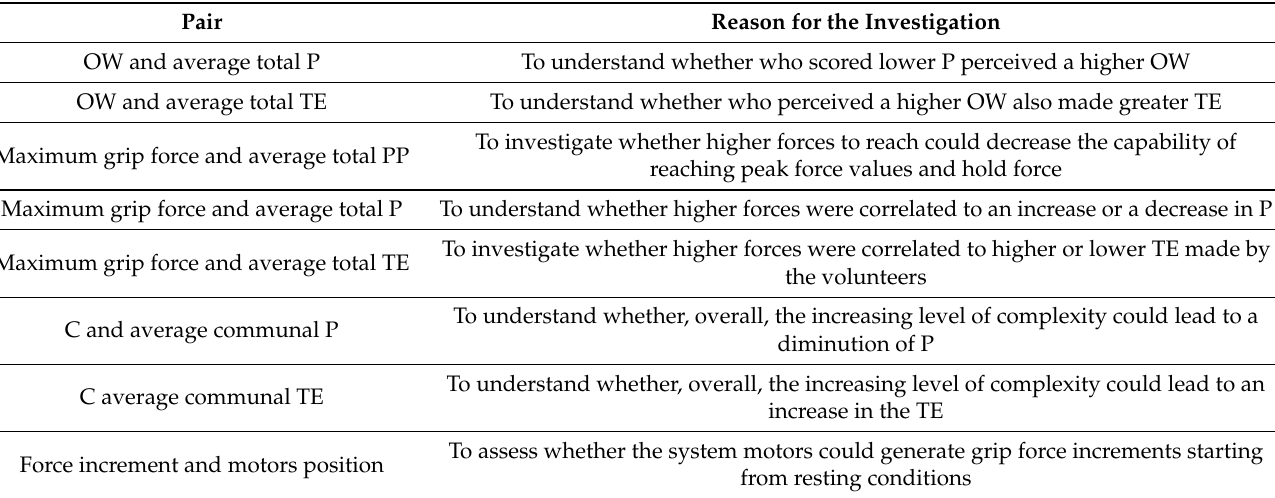
Table 1. Correlation between pairs of